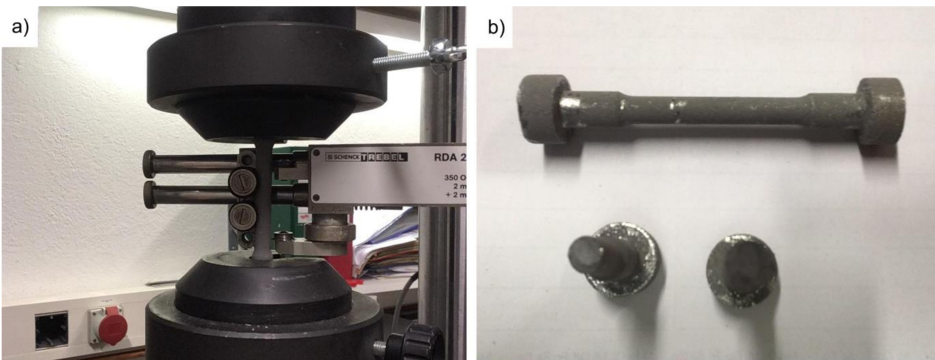
Figure A2. Pictures of 3D-printed tensile strength samples from Ti6Al4V powder: ( a ) overview of the test setup; ( b ) the sample overview after the